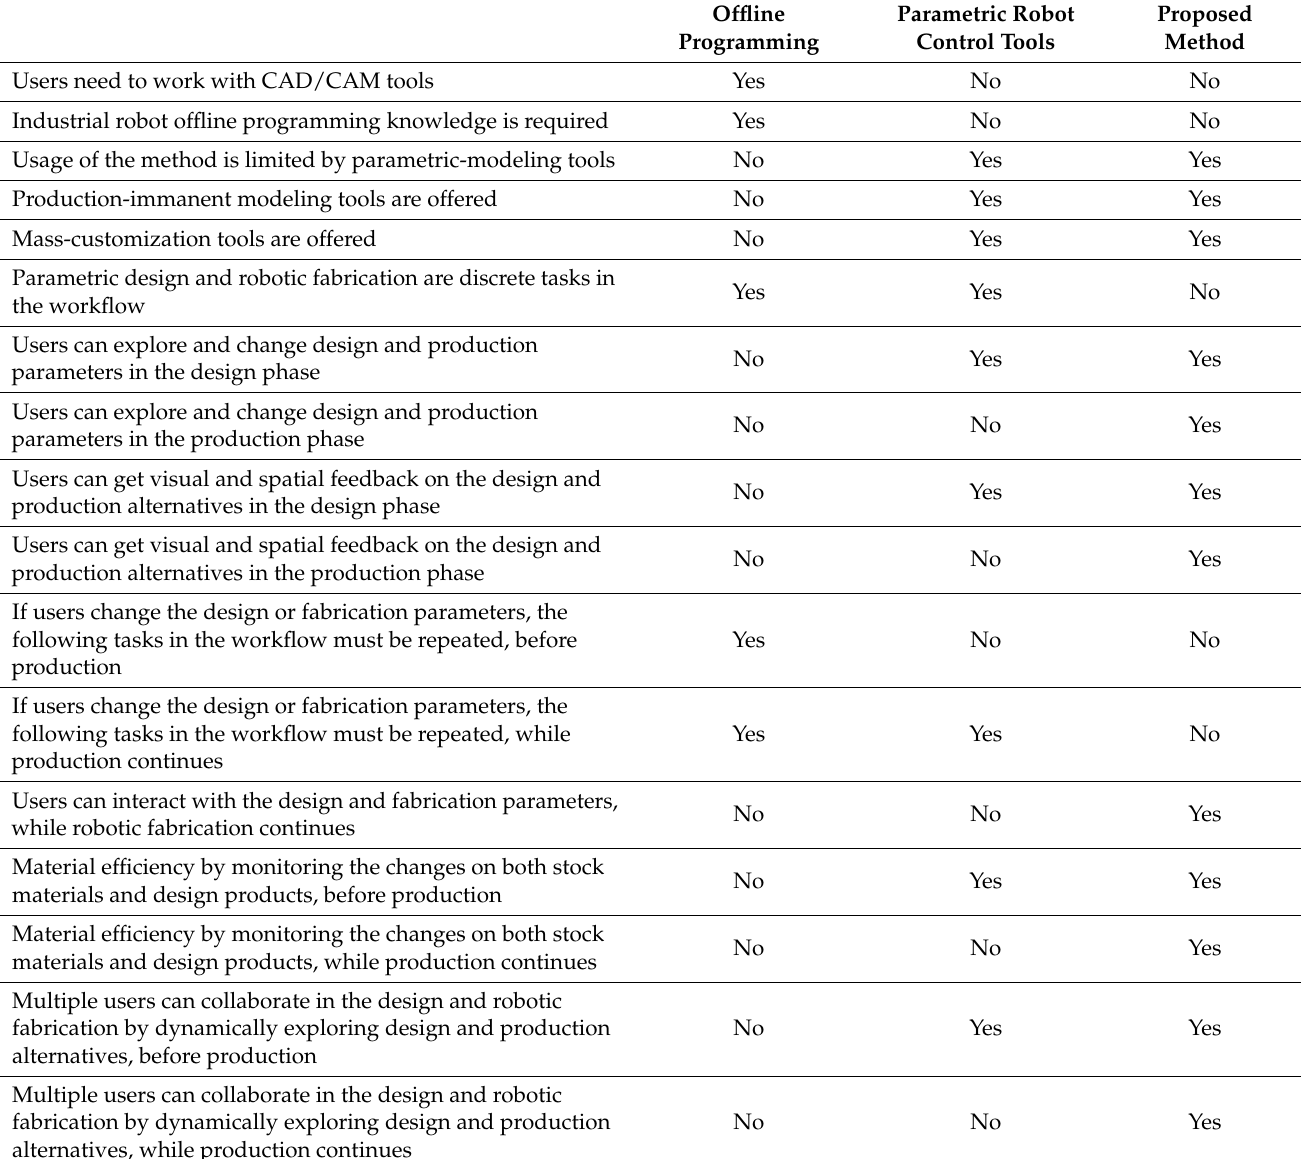
Table 1. Comparison chart of robotic-fabrication offline programming, parametric robot-control tools, and the proposed method.